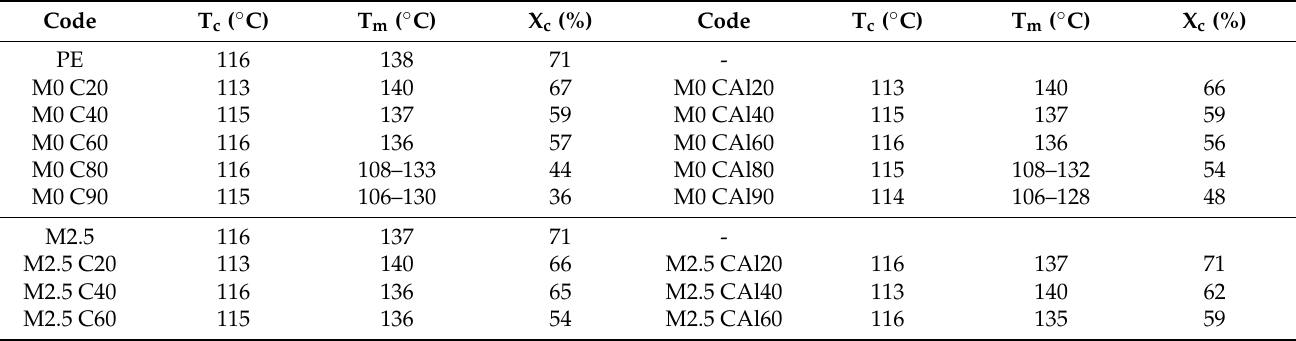
Table 2. Results of DSC analysis of all materials realized: crystallization temperature (T c ), melting temperature (T m ), and crystallinity (X c ). The crystallinity content is calculated on the basis of the polymeric content (recycled PE + the PE fraction of MC +